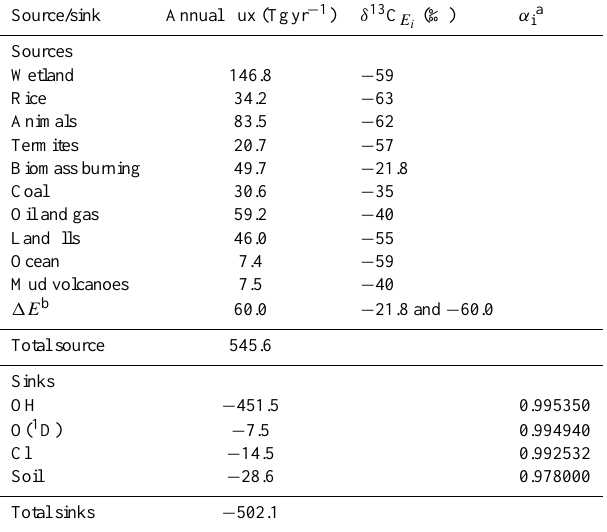
Table 1. Average source and sink strengths of CH 4 for 1980–1989, isotopic ratios ( δ 13 C E ) and fractionation factors ( α i i